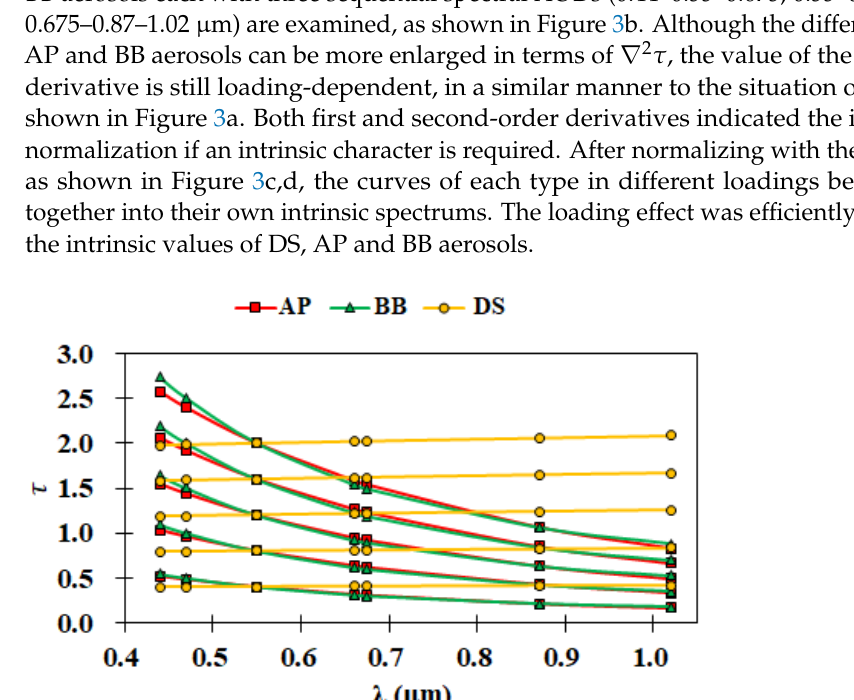
Figure 2. The simulated spectral aerosol optical depths (AODs) at 0.44, 0.47, 0.55, 0.66, 0.675, 0.87 and 1.02 μ m for DS (yellow), BB (green) and AP (red) aerosols under AOD (0.55 μ m) values of 0.4, 0.8, 1.2, 1.6 and 2.0 from the 6S (Second Simulation of a Satellite Signal in the Solar Spectrum) model with the experimental dataset.